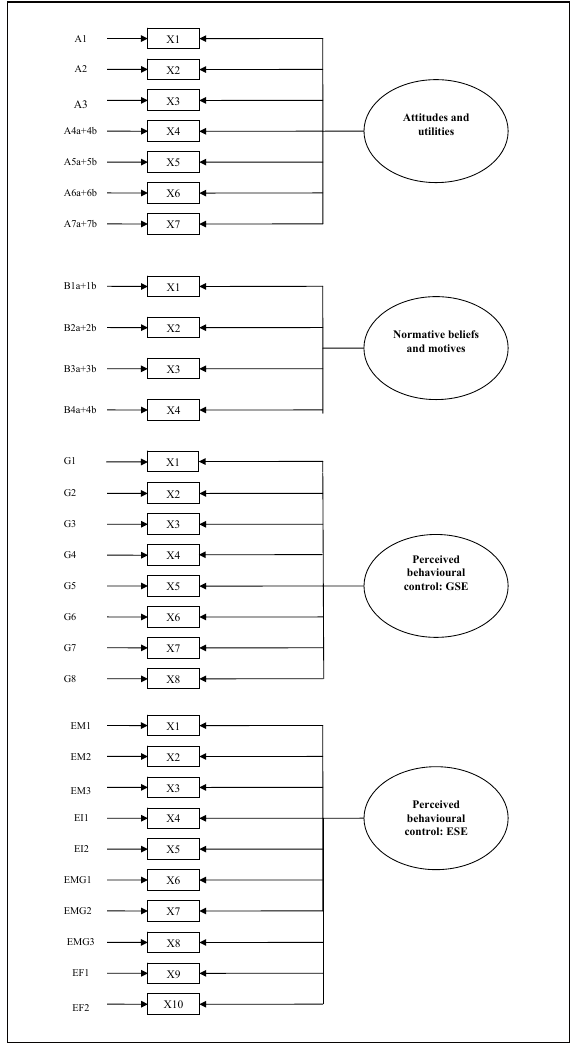
Figure1 Data model of observed indicators and latent factors for antecedents to entrepreneurial